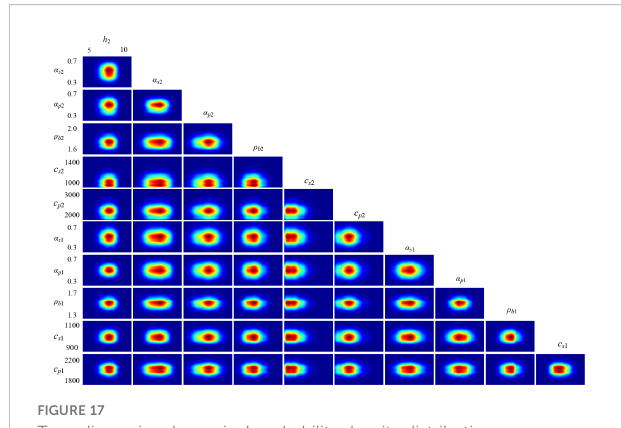
FIGURE 17 Two-dimensional marginal probability density